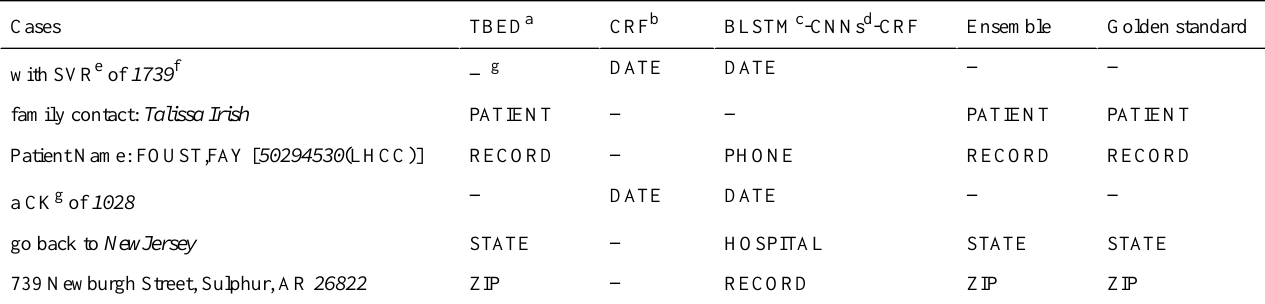
Table 7. Examples of transformation-based error-driven learning contribution to ensemble